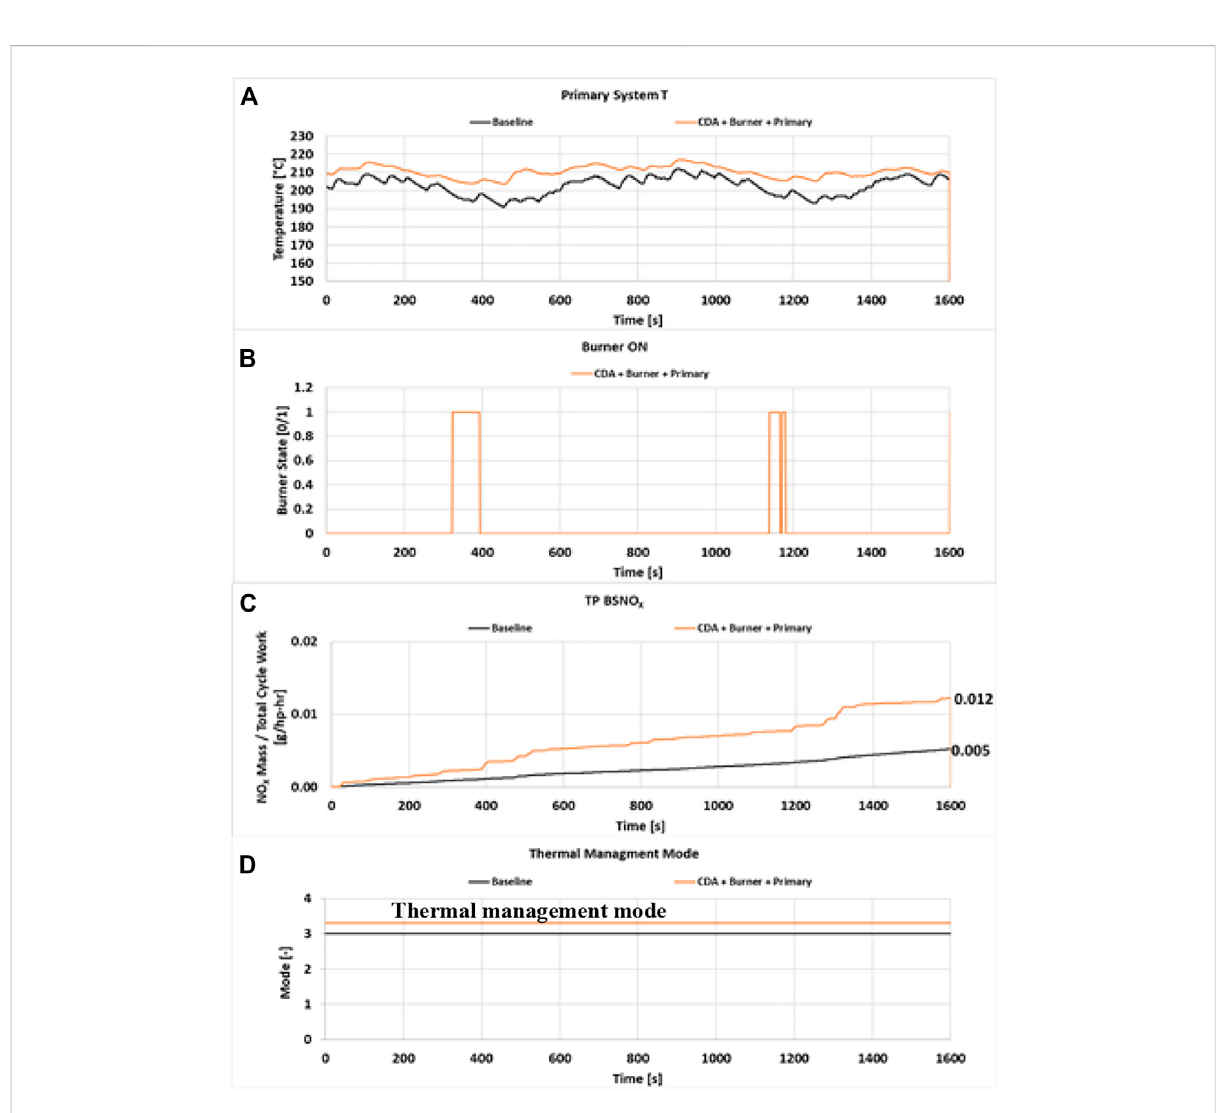
FIGURE 13 BEV measurement comparison between Baseline and CDA + Burner + Primary systems. (A) Primary system temperature, (B) Burner state, (C) Cumulative TP BSNOX, (D) Engine mode